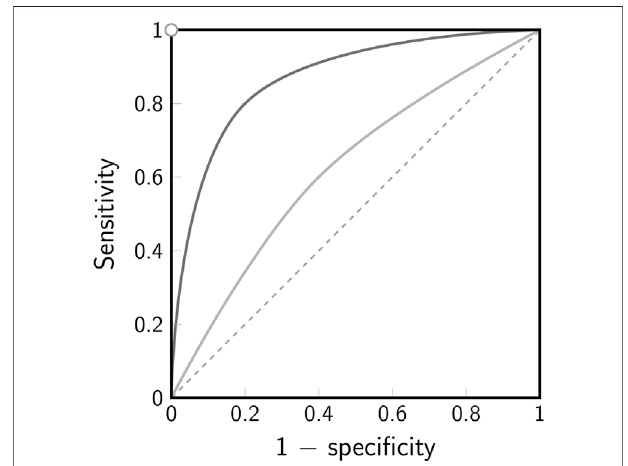
FIGURE 4 | Receiver operating characteristic (ROC). The ROC curve illustratesthetrade-offbetweensensitivityandspeci fi cityforabinaryclassi fi er. The true positive rate (sensitivity) is plotted against the false positive rate (1- speci fi city). Note that for a hypothesis test the false positive rate corresponds to the chosen level of signi fi cance α . The white dot in the top left corner indicates the point of perfect discrimination, the dashed line indicates the line of no discrimination. The solid lines indicate two scenarios for a binary classi fi er with low discrimination (light gray) and better discrimination (dark